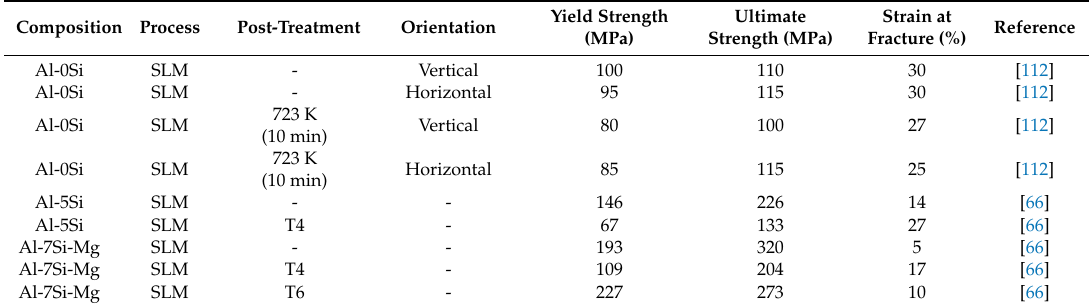
Table 2. Summary of the tensile properties of Al-xSi alloys. Results of the Al-12Si alloy will be reported in Table 3